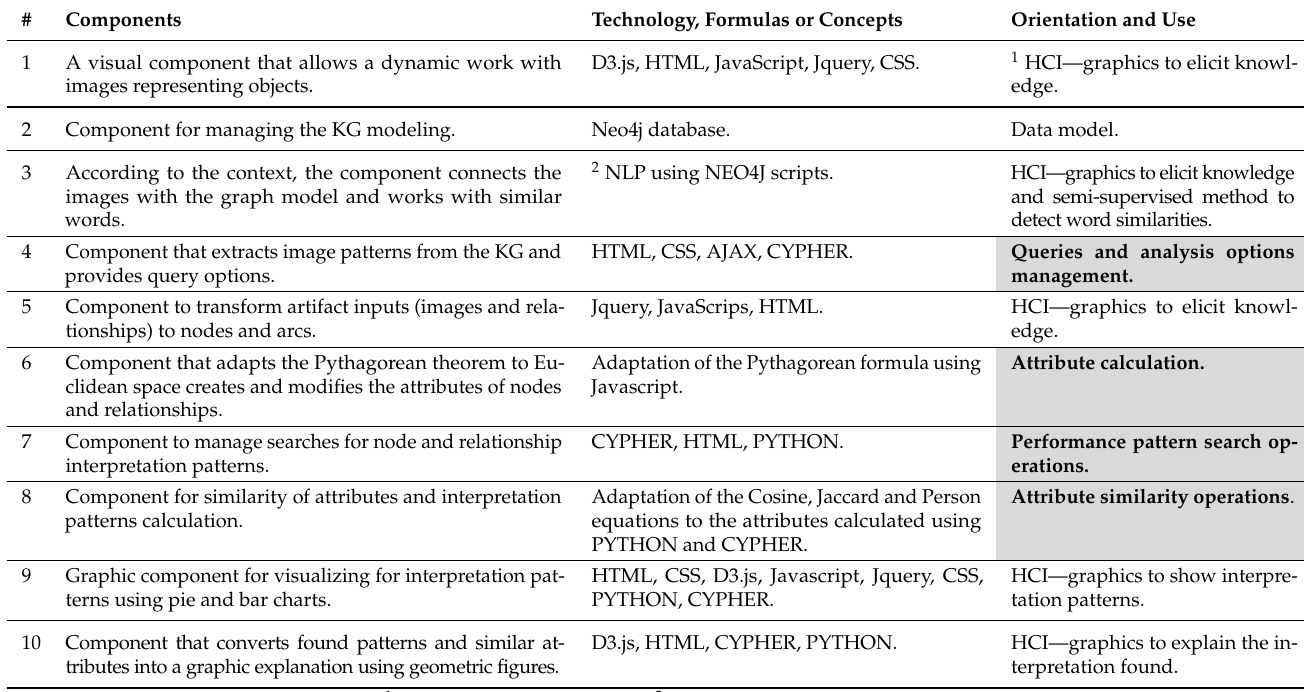
Table A1. RYEL system: Components and technology.